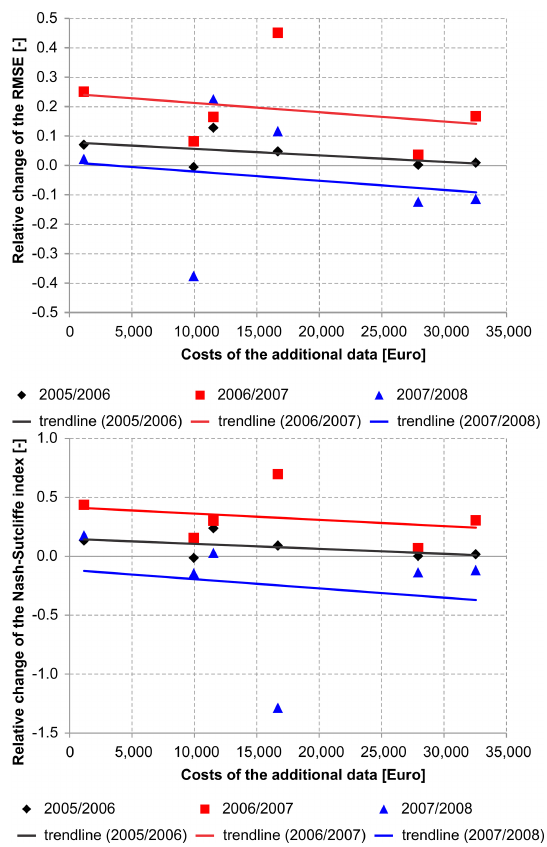
Figure 10. (a) Relationship between the costs of the additional data and the relative change of the RMSE (comparison of second and third prediction). (b) Relationship between the costs of the ad- ditional data and the relative change of the Nash–Sutcliffe index (comparison of second and third prediction).